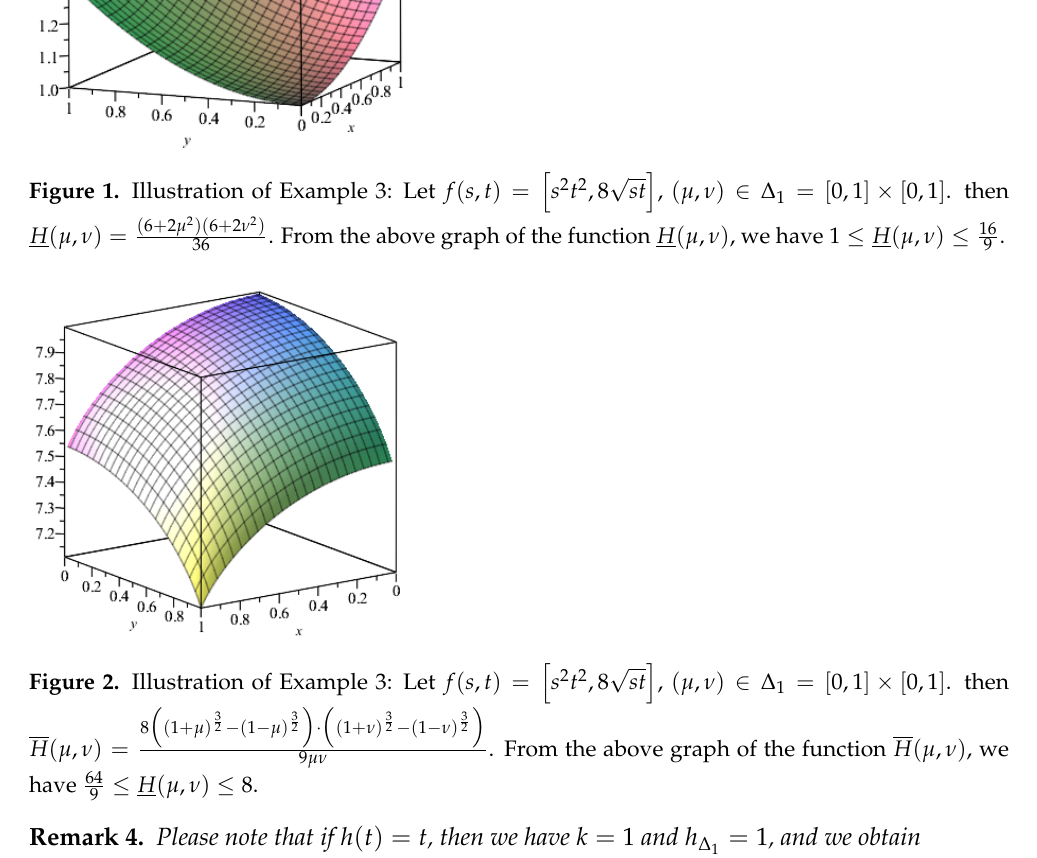
2 )( 6 + 2 ν 2 ) . From the above graph of the function H ( µ , ν ) , we have 1 ≤ H ( µ , ν ) ≤ 16 36